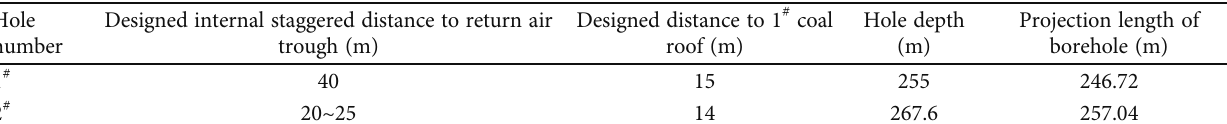
Table 3: 1201 drilling hole design and actual layout parameters of directional drilling fi eld with return air downhole.